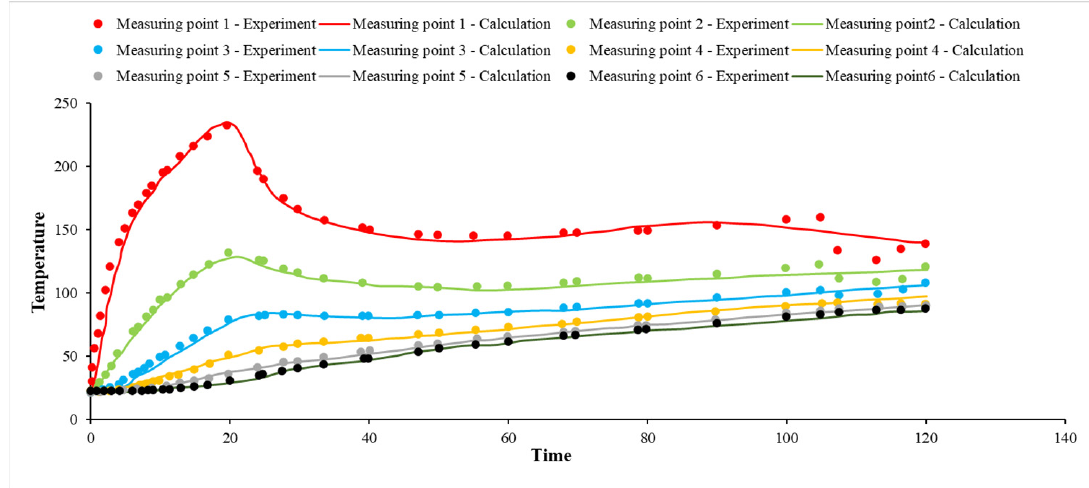
Figure 3. Comparison of experimental and calculated temperature for E-CSS.